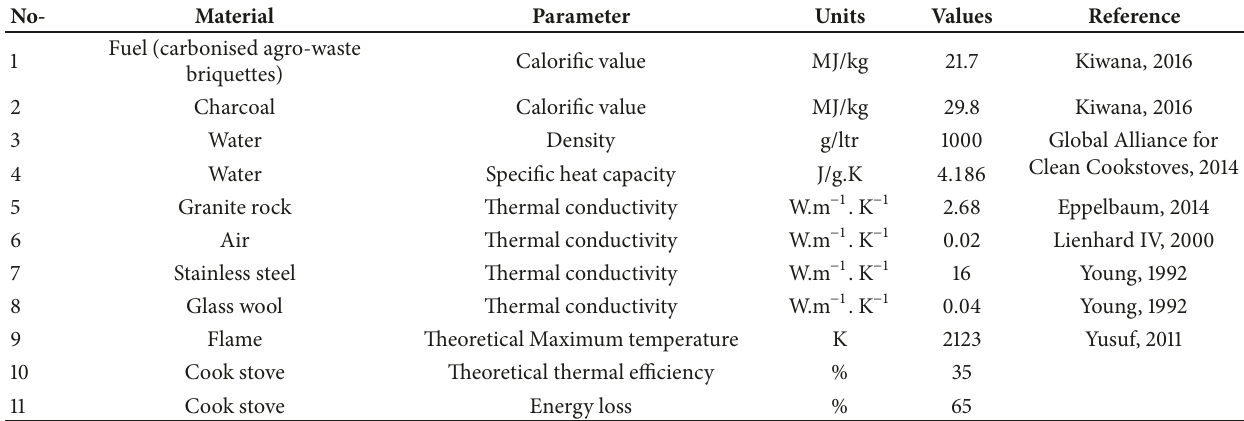
Table 1: Thermal design assumptions for the cooking stove.